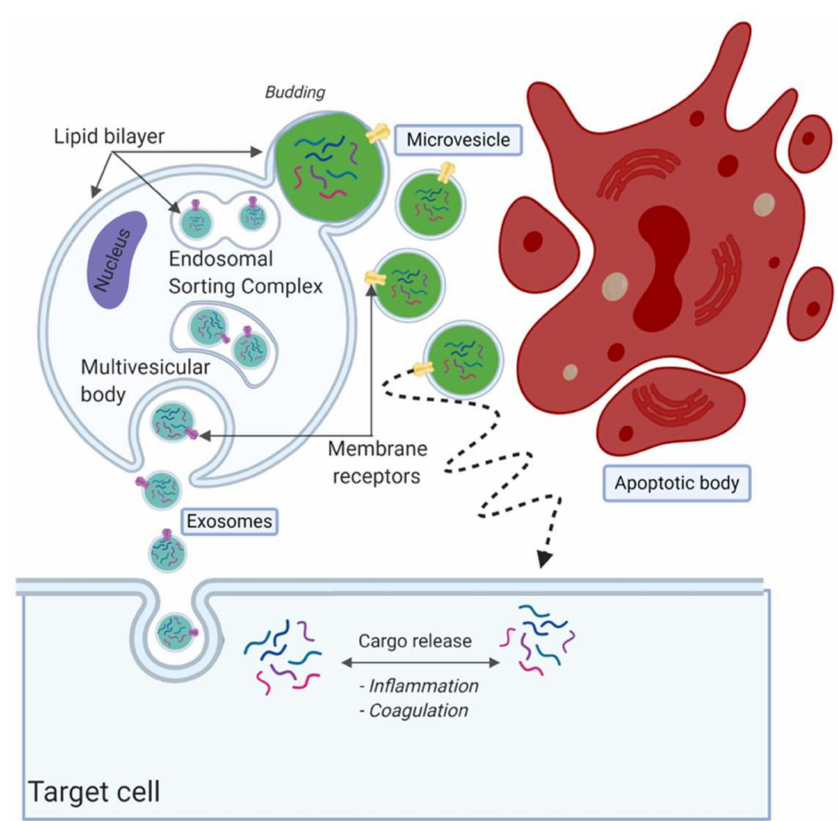
Figure 2. Overview of extracellular vesicle (EV) subpopulations and formation routes. EVs are often divided into three subpopulations, namely, exosomes, microvesicles and apoptotic bodies. Exosomes are considered the smallest population, released by fusion with the plasma membrane. Microvesicles are secreted by blubbing, as can be seen in green. Lastly, apoptotic bodies are fragments released from cells during apoptosis, considered to be the largest in size. Created with